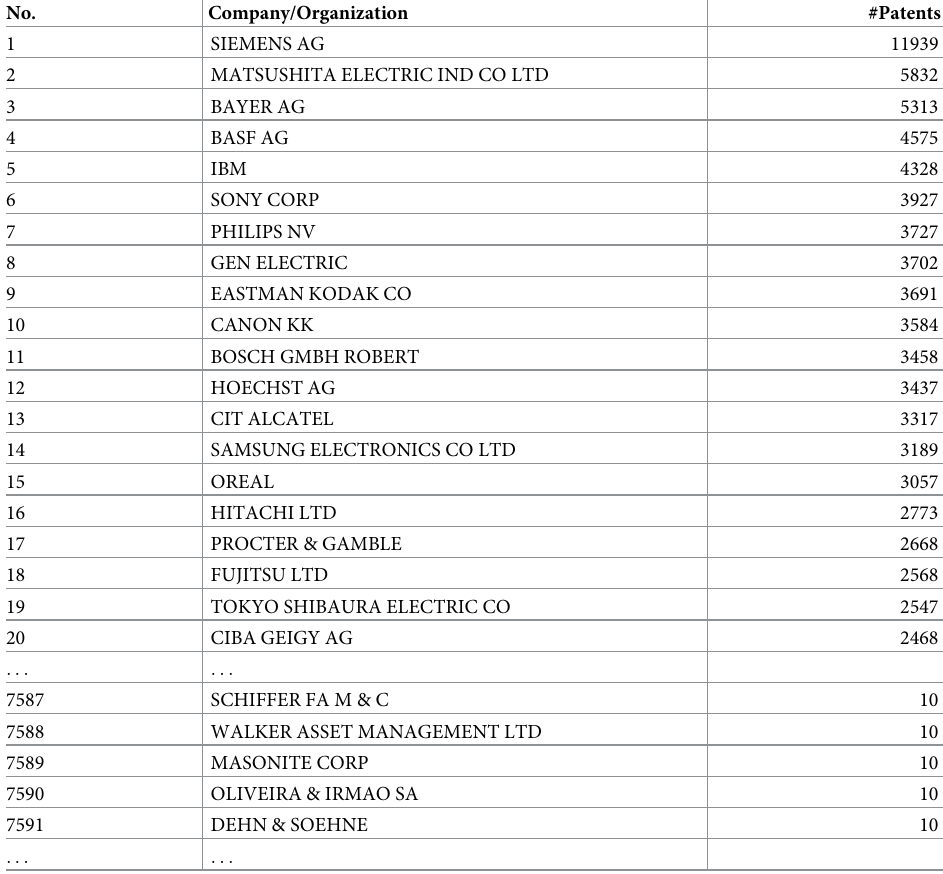
Table 4. Patent distribution for